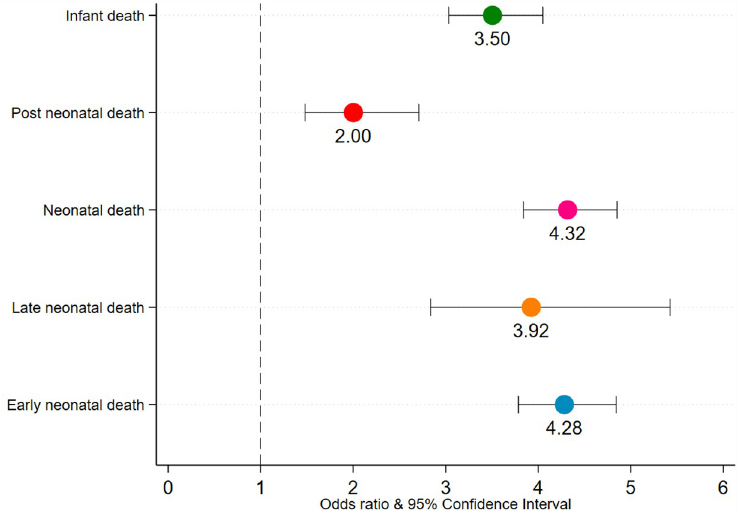
Fig 6. Adjusted odds ratio of ENND, LNND, NND, PNND, and IND for preterm birth among most recent births, NFHS-4, India, 2015–16. Note. 1. Odds ratios are significant at p < 0.05, ENND Early Neonatal Death, LNND Late Neonatal Death, PNND Post Neonatal Death, NND Neonatal Death, IND Infant Death. Odds ratio are adjusted for birth order, index child C-section, > = 4 ANC visit, > 100 IFA tablets, > = 2 TT injection, index birth wanted, sex of child mother’s age at conception, mother’s height, mother’s schooling, caste, religion, wealth quintiles, urban-rural residence, and state-region.